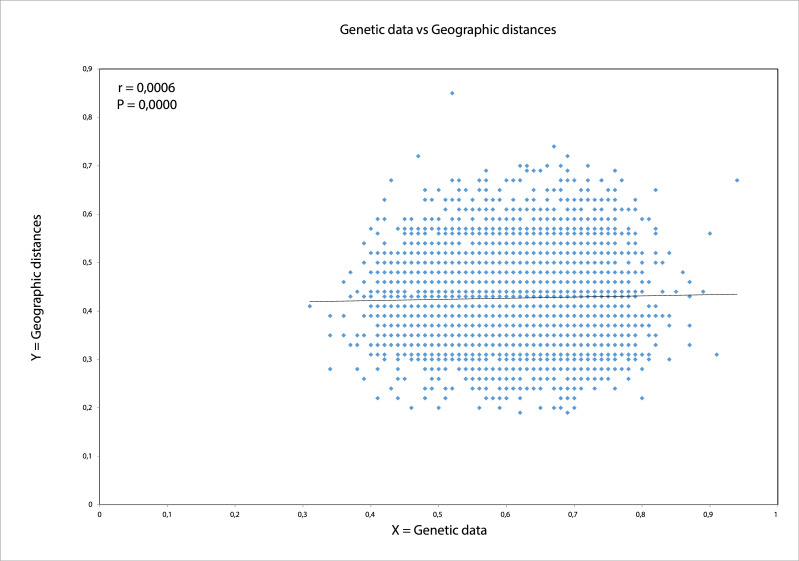
Mantel test (r = 0.001) showed significant but low correlation between genetic and geographic distances for apple fruit moths (A. conjugella) (n = 669) on the Scandinavian Peninsula in 2016.